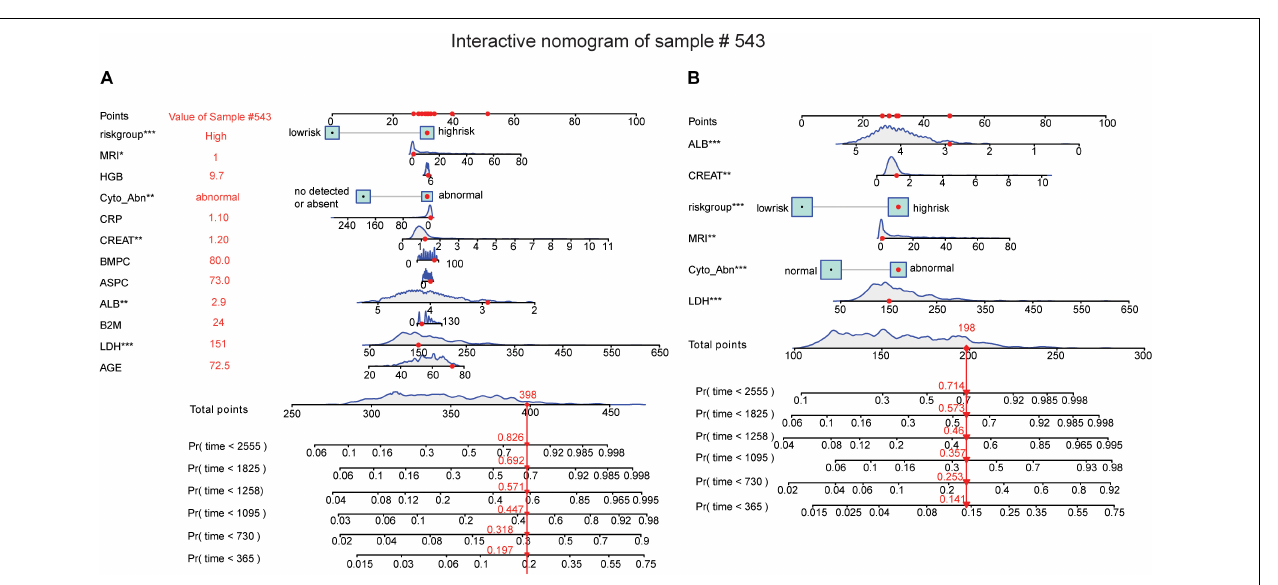
FIGURE 7 | Nomogram predicting the probability of 1-year, 3-year, 5-year, and 7-year overall survival for sample GSM592937. (A) Eleven clinical risk indicators and five-gene risk group predicting the 1 to 7-year overall survival probability. (B) Five clinical risk indicators and five-gene risk group predicting the 1 to 7-year overall survival probability (* p < 0.05, ** p < 0.01, and *** p <